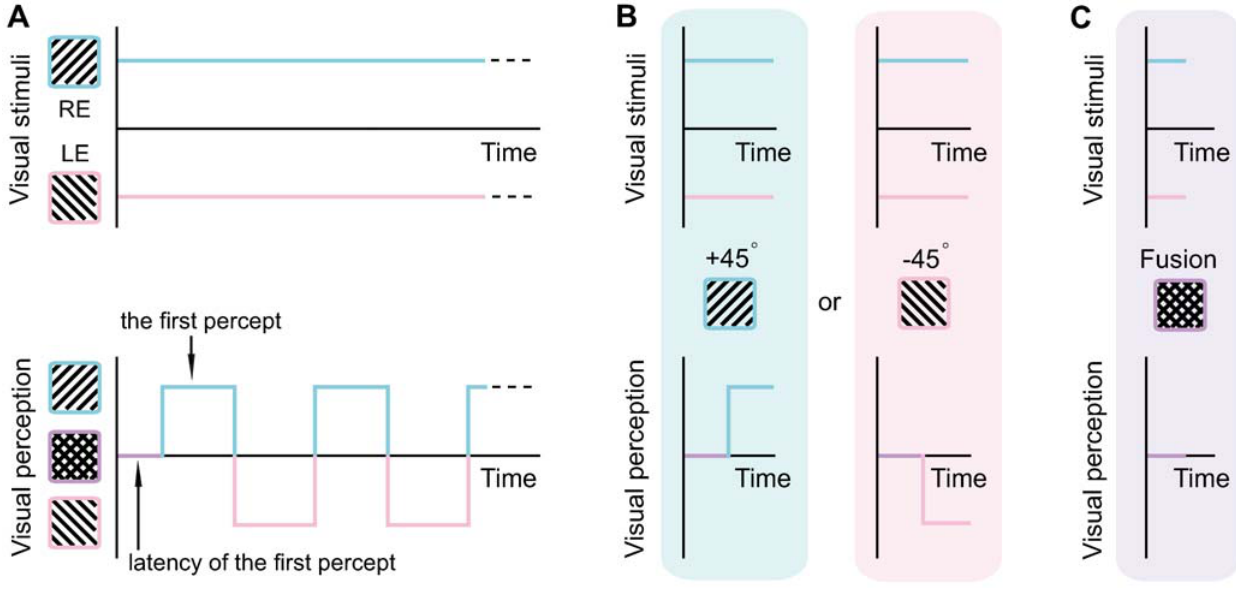
Figure 1. Schematic depiction of binocular rivalry and experimental paradigms. (A) To induce binocular rivalry, a pair of orthogonal gratings (tilted + 45 u and 2 45 u away from the vertical) were separately presented to the two eyes of the human subjects, and subjects experienced the alternating dominance between one grating and the other. Between the stimulus onset and the first percept, there existed a short period during which subjects experienced the fusion of the two gratings, rather than the complete dominance of one grating over the other. (B) and (C) To measure the first percept and its latency, rivalry stimuli were briefly presented for a duration varied from 10 msec to 500 msec, and subjects reported their perception through a three-alternative forced choice ( + 45 u grating, the 2 45 u grating, or the fusion of two gratings). The trails in which subjects reported the fusion perception were taken into account only when we calcualted the latency of the first percept, and different conditions of stimulus duration were combined in the analyses except for calculating this latency.